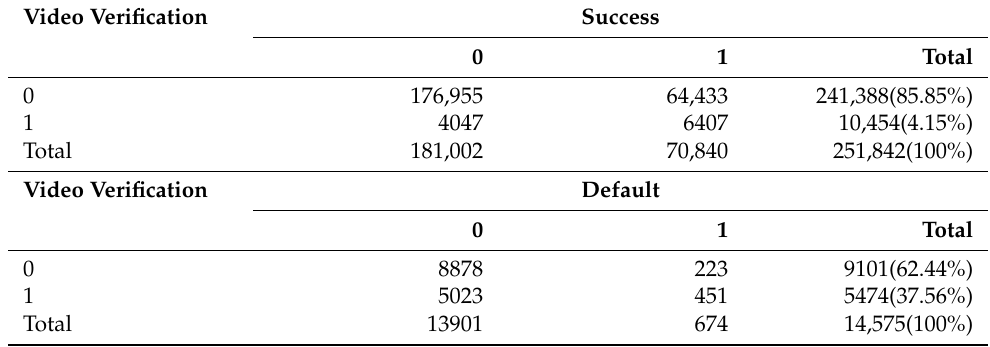
Table 5. Video Verification Distribution